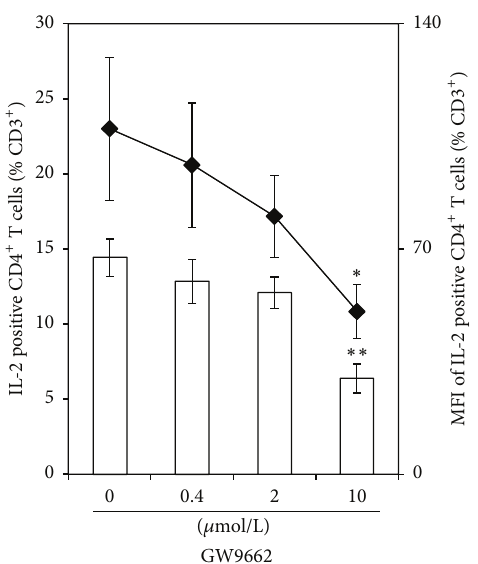
Figure2:GW9662dose-dependentlydownregulatesIL-2expressioninT-helpercells.PBMCwereincubatedforatotalof24 hwithincreasing concentrations of GW9662. After 19 h, cells were activated for further 5 h. IL-2 expression of T-helper cells was flow cytometrically analyzed. Data are expressed as means ± SEM of 𝑛 = 6 . Right scales denote mean fluorescence intensity (MFI) depicted as aligned dots. The dose- dependent effect is statistically significant with ∗∗ 𝑃 < 0.01 and ∗ 𝑃 < 0.05